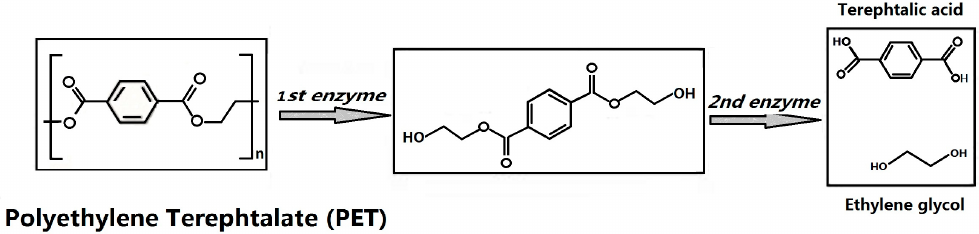
Figure 3. Polyethylene tetraphtalate biodegradation by Ileonella sakaiensis 201-F6.